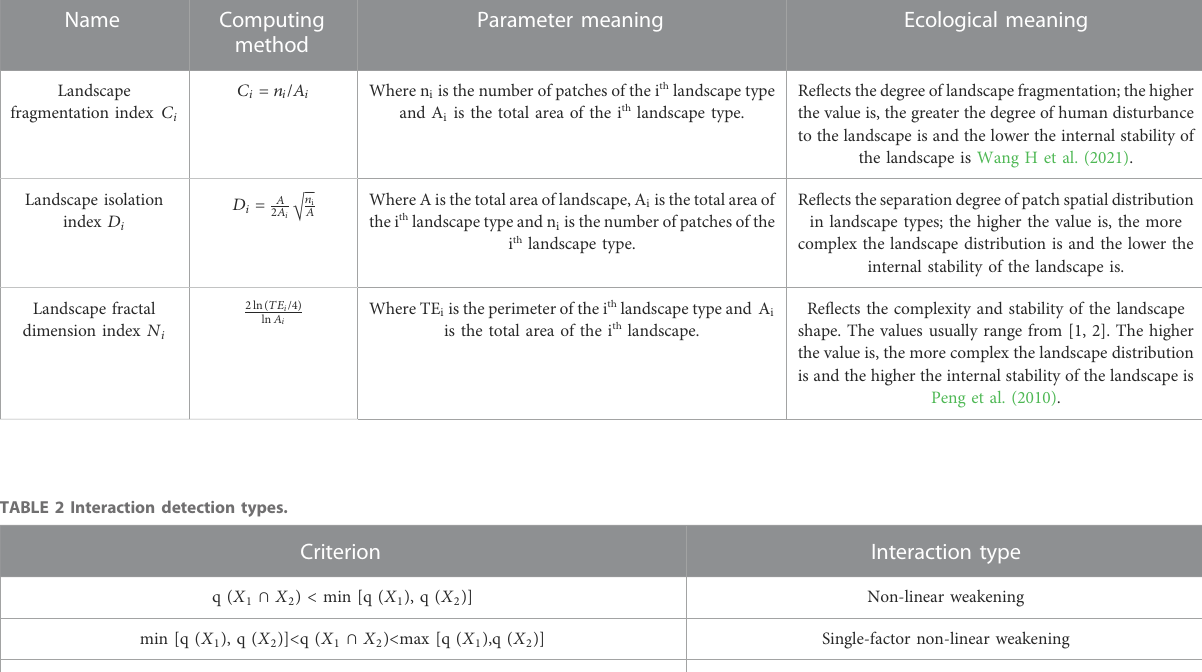
TABLE 1 Calculation formulas of each subindex in the landscape disturbance matrix.